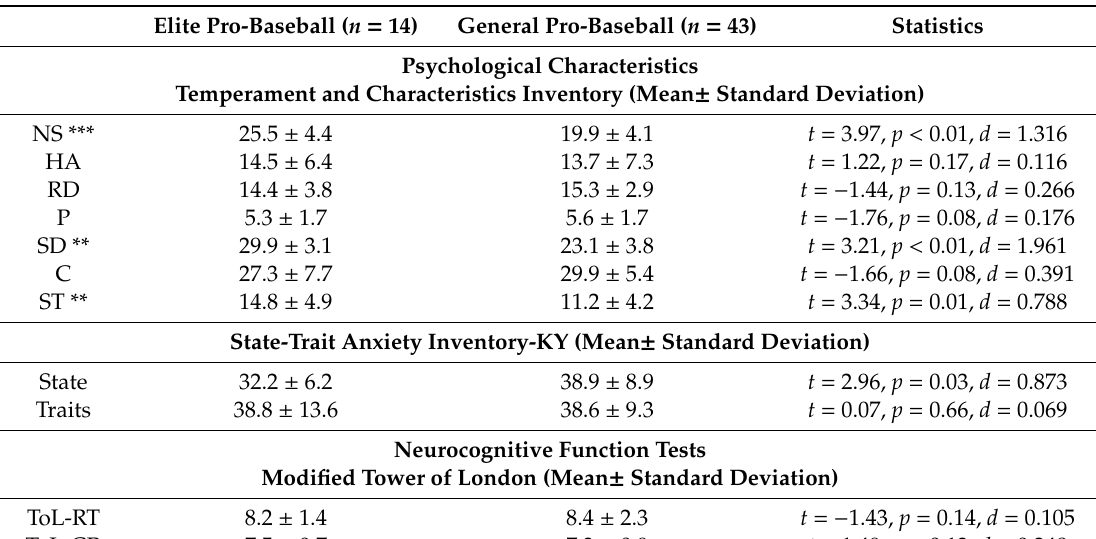
Table 4. Comparison of psychological and cognitive characteristics between elite pro-baseball players and general pro-baseball